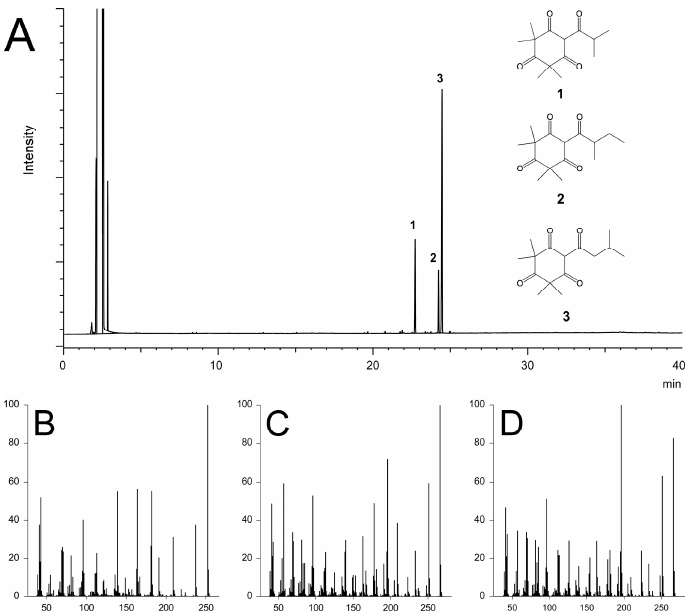
Figure. 1. Gas chromatogram of the triketone fraction and structures of triketones ( A ) and mass spectra ( B – D ). 1 : flavesone ( B ); 2 : isoleptospermone ( C ); 3 : leptospermone ( D